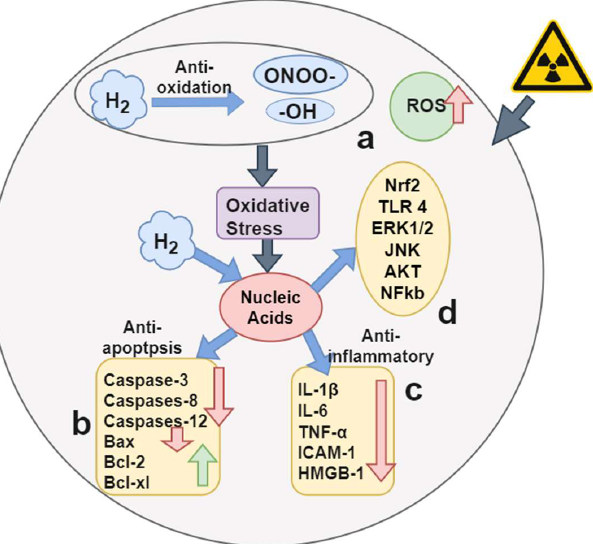
Figure 2. Biological effect mechanism of hydrogen. ( a ) H 2 selective removal of -OH and ONOO−. ( b ) H 2 stimulating human apoptosis factor cell regulation. ( c ) H 2 promoting human inflammatory factor cell regulation. ( d ) Unknown molecular mechanism of H 2 regulation.